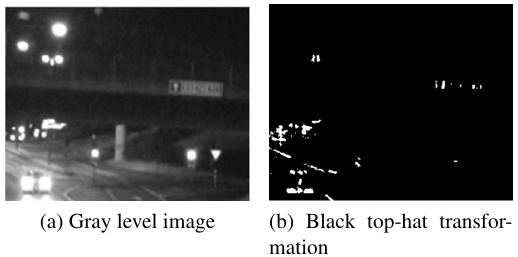
Figure 6. Features based on black top-hat